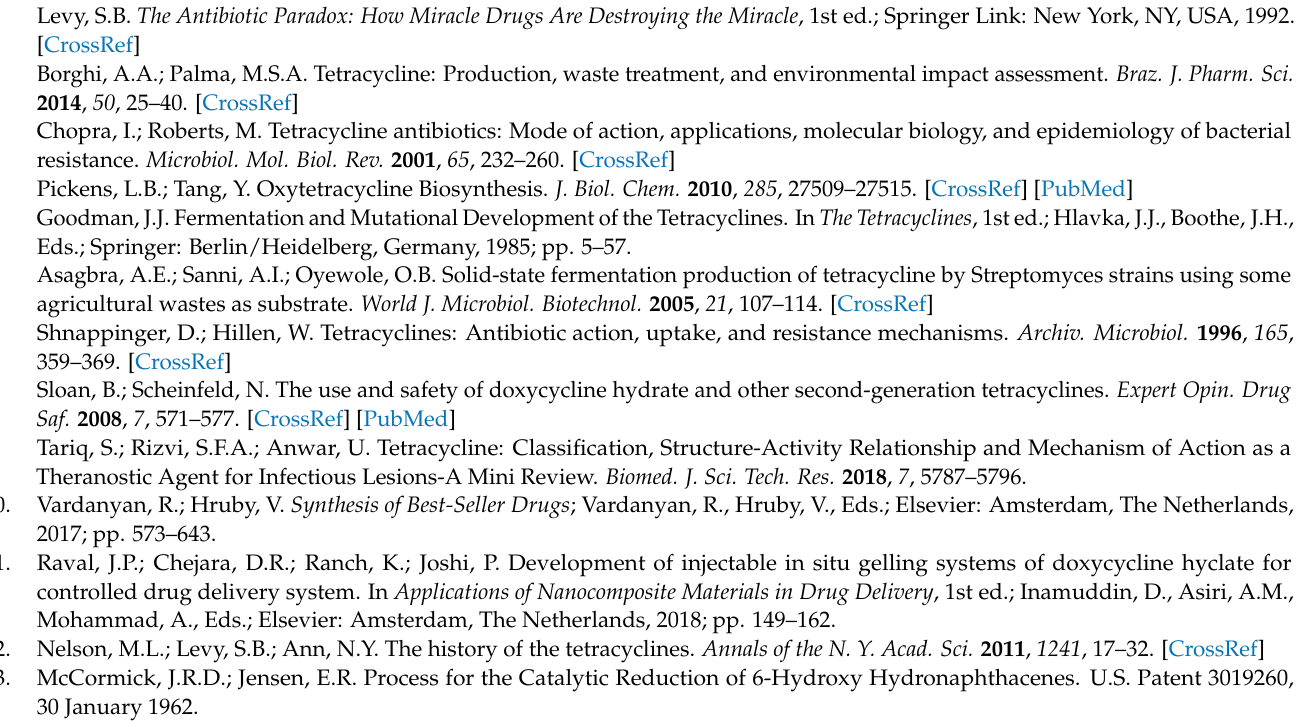
RT. Figure S3: DQF-COSY spectrum of reaction products obtained in presence of β -cyclodextrin. Figure S4: 1H-13C-HMQC spectrum of reaction products obtained in presence of β -cyclodextrin. Figure S5: 1H-13C-HMBC spectrum of reaction products obtained in presence of β -cyclodextrin. Fig- ure S6: DQF-COSY spectrum of α -doxycycline reference compound. Figure S7: 1H-13C-HMQC spec- trum of α -doxycycline reference compound. Figure S8: 1H-13C-HMBC spectrum of α -doxycycline reference compound. Figure S9: 1H-NMR spectrum of β -doxycycline (reaction products obtained without β -cyclodextrin). Figure S10: COSY spectrum of β -doxycycline (reaction products obtained without β -cyclodextrin). Figure S11: 1H-13C HMQC spectrum of β -doxycycline (reaction products obtained without β -cyclodextrin). Figure S12: 1H-13C HMBC spectrum of β -doxycycline (reaction products obtained without β -cyclodextrin). Figure S13: Example of HPLC-MS trace of a